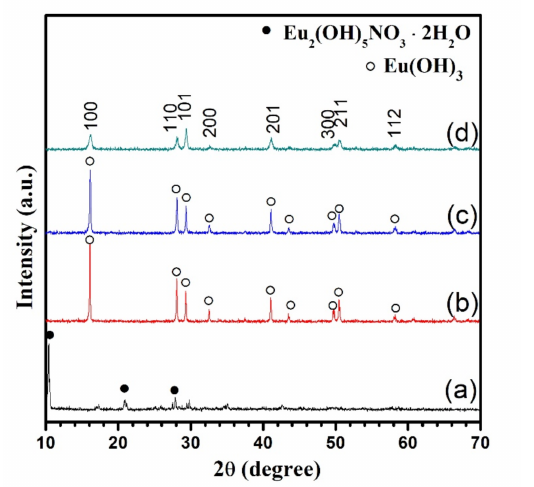
Figure 3. XRD patterns of the products obtained at 160 ◦ C for 24 h as a function of the pH value of the starting solution. The pH value used is 7.26 ( a ), 8.99 ( b ), 10.48 ( c ), 12 ( d